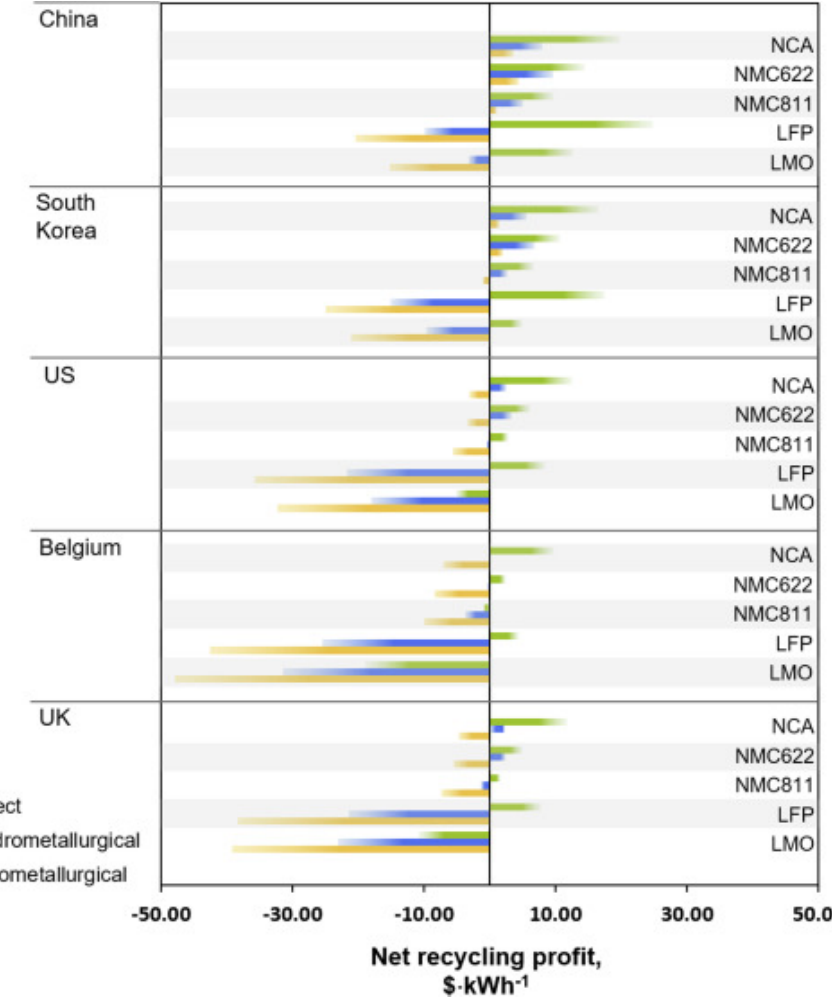
Figure 8. Net recycling profits for commercial EV battery packs. Reprinted from iScience, Vol. 24, Lander et al. [4], Financial viability of electric vehicle lithium-ion battery recycling, no. 7, Copyright (2022), distributed under Creative Commons Attribution License.